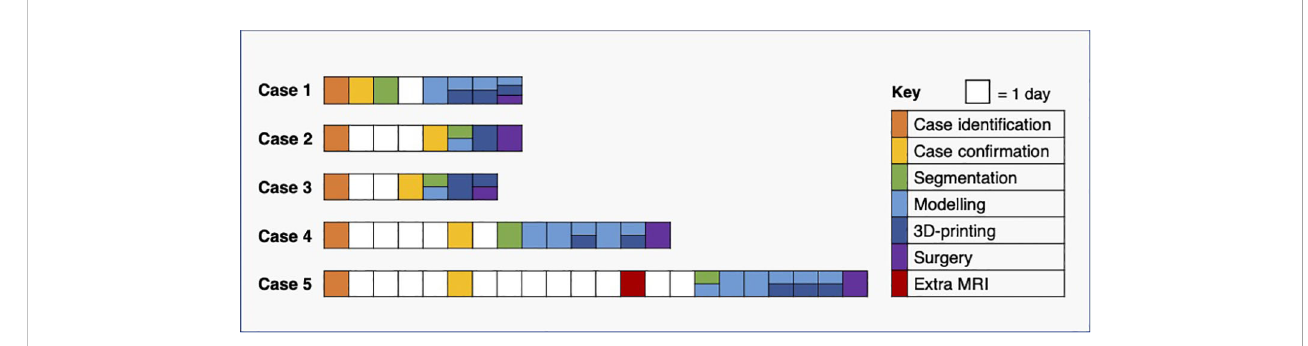
FIGURE 13 Pathway timelines for each case. All baseline CT imaging took place prior to case identi fi cation (see Figure 12).